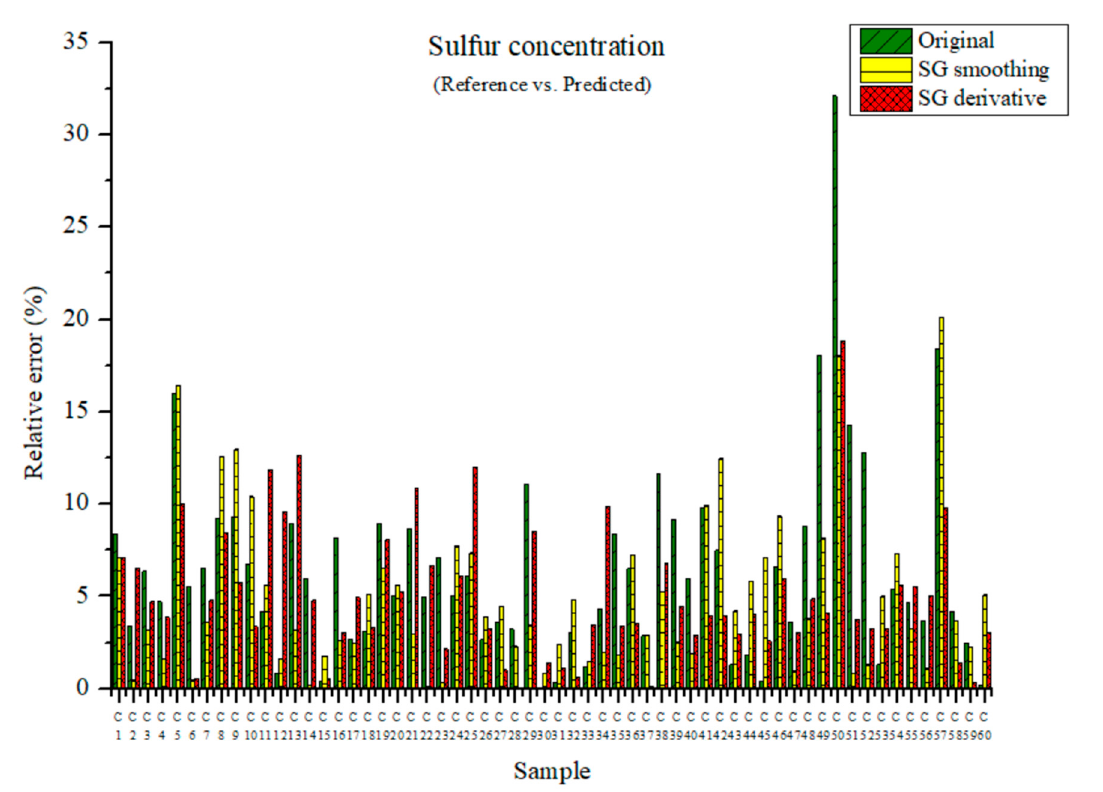
Figure 15. Comparison of relative errors between measured and predicted sulfur concentrations for the PLSR models using the original data and pre-processed data.